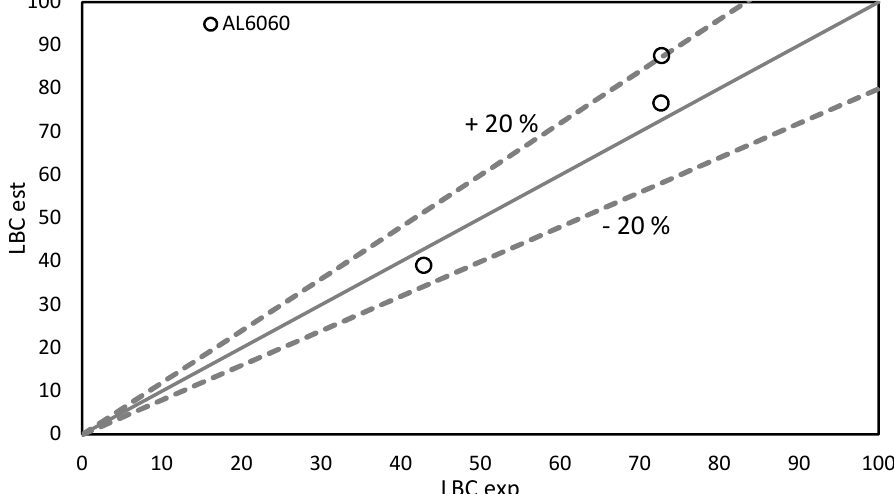
Figure 12. Comparison between the experimental results (LBCexp) and the resulting estimations (LBCest).